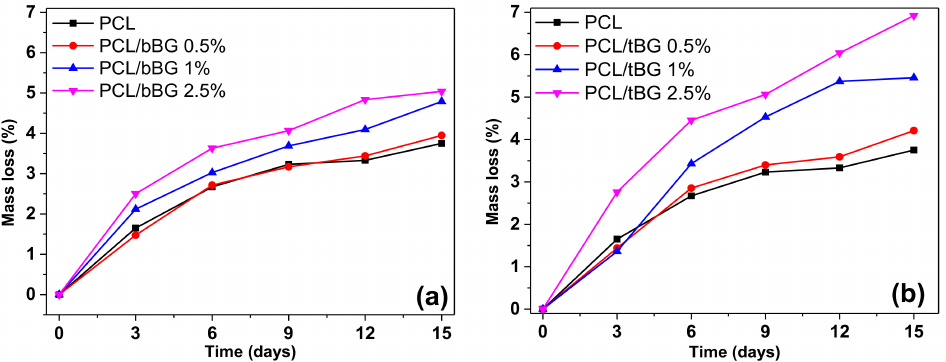
Figure 11. Plots of mass loss vs time of enzymatic degradation of ( a ) PCL/bBG and ( b )